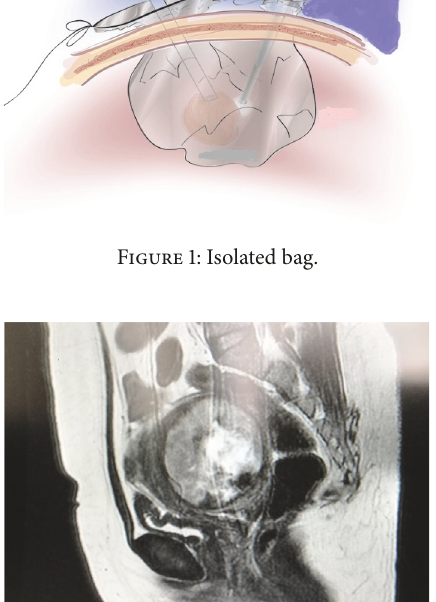
demonstrated a hypodense nodular lesion with a diameter of 75 mm that extended to the right adnexal region and MRI with contrast was performed on the patient. MRI revealed a mass with a hypovascular appearance following a heterogeneous and hypointense IV contrast material with a diameter of 8 mm, which appeared to displace the posterior